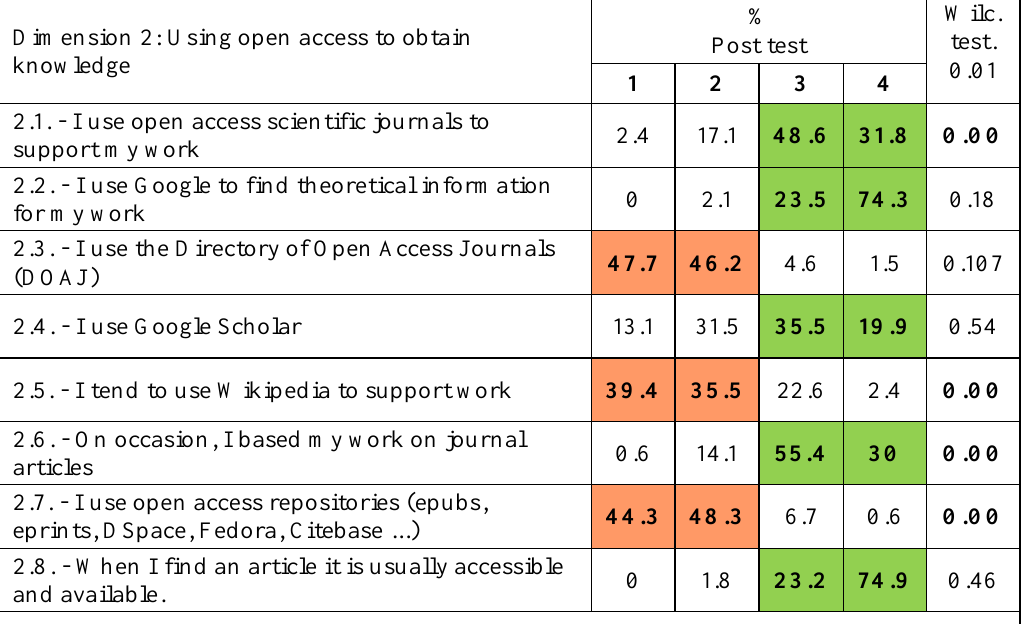
Table 3 Dimension 2. Using OA to Access Knowledge. Frequencies in Post-Test and Wilcoxon Test Dimension 2: Using open access to obtain